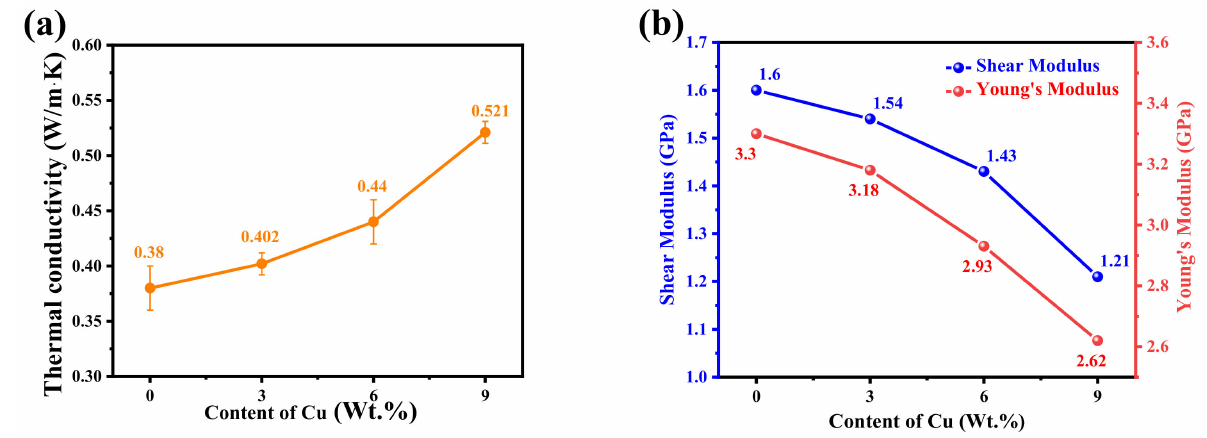
Figure 5. ( a ) Thermal conductivity, ( b ) Young’s Modulus and Shear Modulus of Cu/PI.